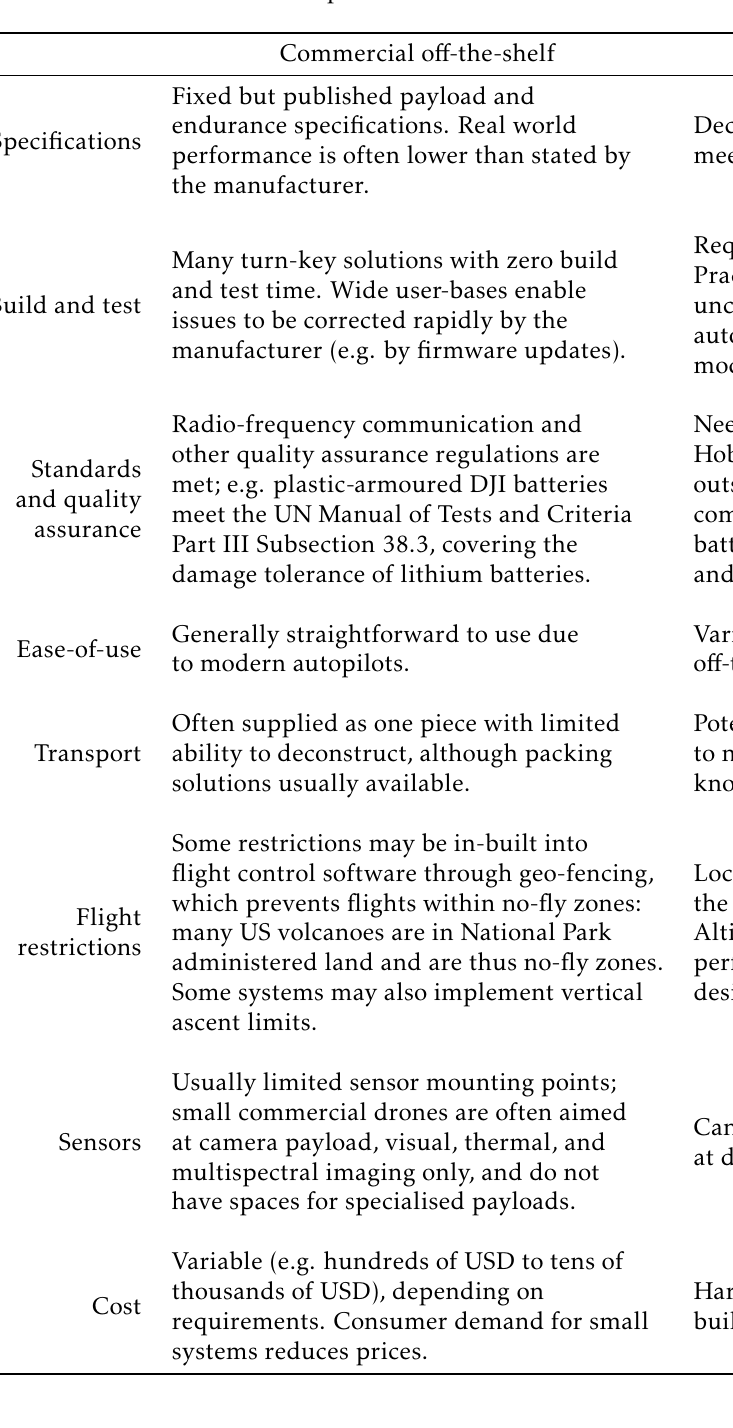
Table 3 – Comparison of characteristics of commercial and custom-built